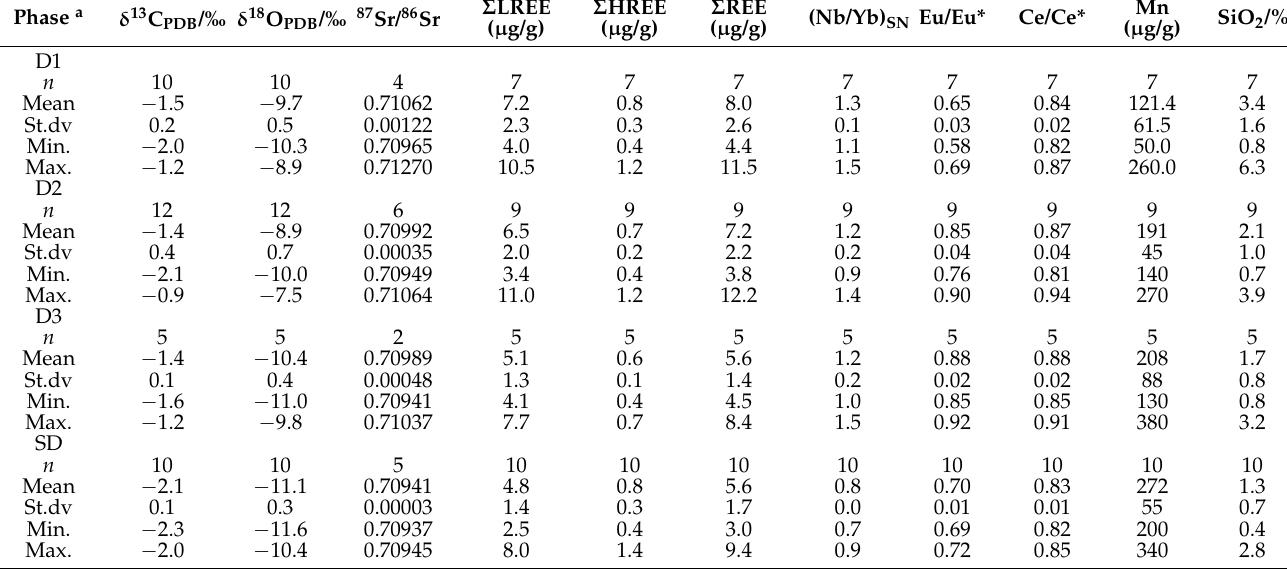
Table 1. Summary of δ 13 C, δ 18 O, 87 Sr/ 86 Sr, REE, and some element statistics of different types of dolomites in the Xixiangchi Formation. Note the δ 13 C, δ 18 O, and REE compositions of some D1, D2, and SD samples have been previously reported by Liang et al. [45]. See Tables S1–S4 for details.